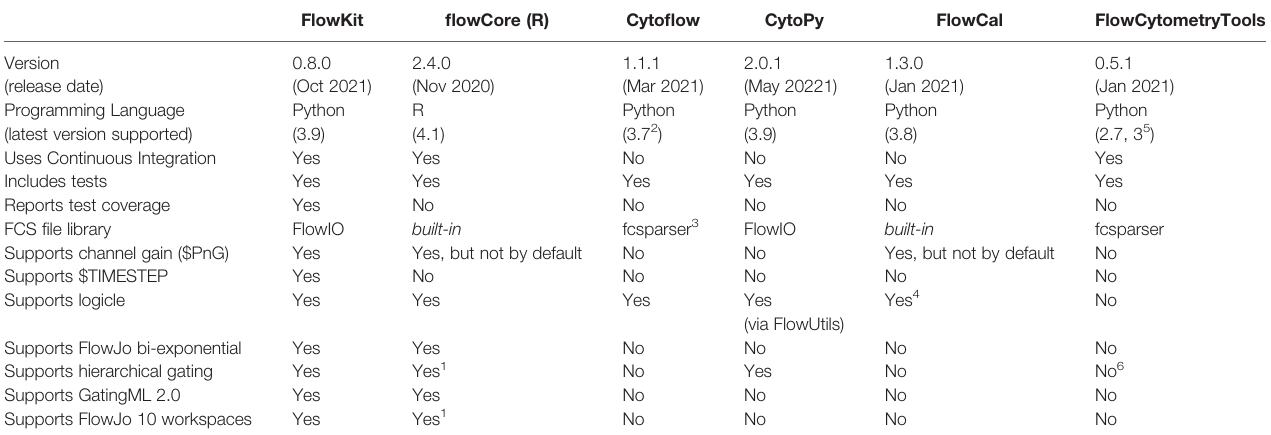
TABLE 1 | Comparison of features between FlowKit and other FCM software